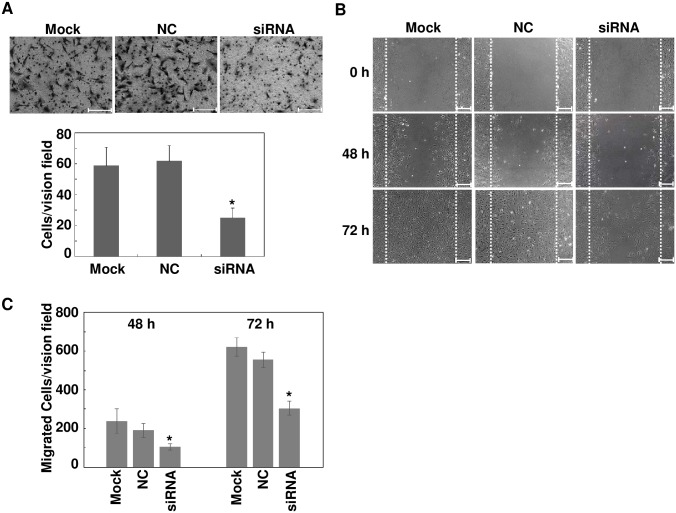
Downregulation of LGR4 decreases ARPE-19 cell migration.ARPE-19 cells were transfected with LGR4 specific siRNA or a scrambled negative control (NC). Transwell (A) and in vitro scratch assays (B) were performed to evaluate the ARPE-19 cell migration. The number of cells that migrated in the transwell assay was quantified by counting the number of cells appearing in the lower chamber in five independent vision fields with a 20X microscope objective. (C) For in vitro scratch assay, cells that migrated into the gap were counted at 48 hours and 72 hours as indicated. Results were expressed as mean ± SD (n = 3, *p < 0.05). All images are representative of at least three independent experiments. Scale bar: 100 μm for transwell assay, and 200 μm for in vitro scratch assay.